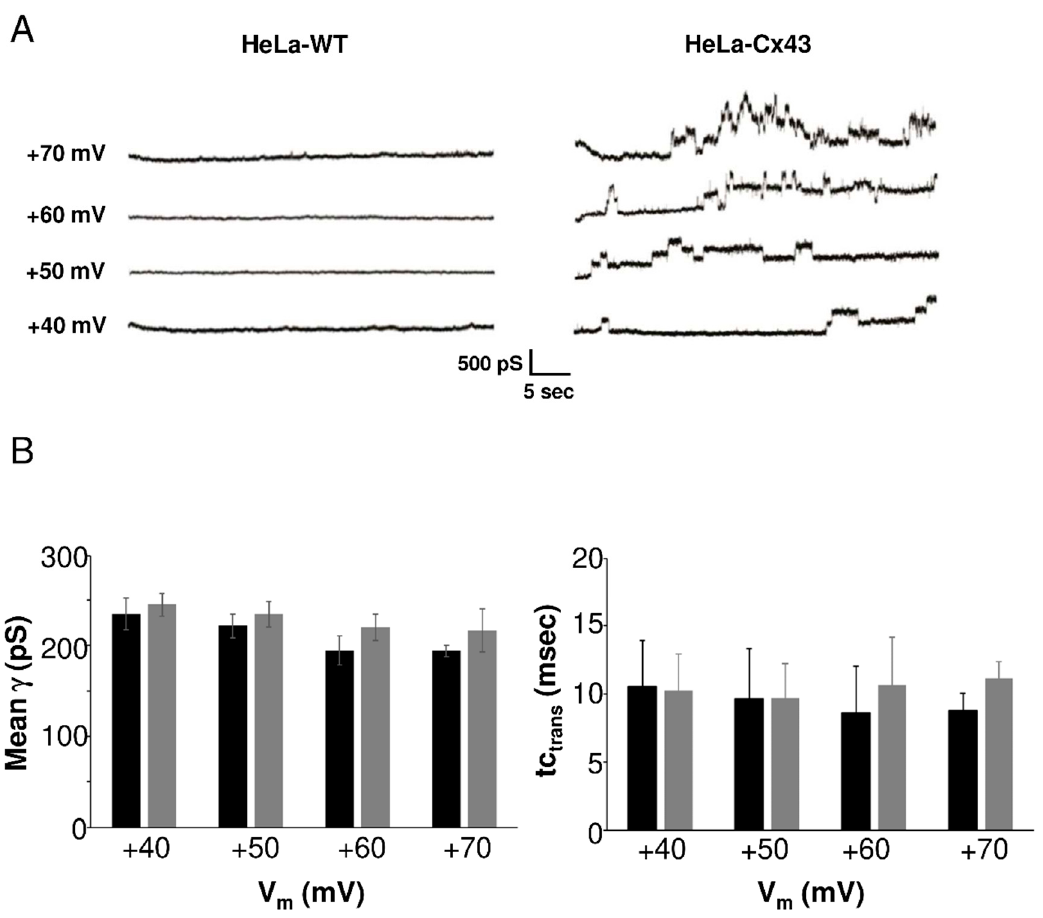
Figure 3. Unitary currents in HeLa-WT and HeLa-Cx43 cells. ( A ) Representative current traces in response to stepping positive membrane potentials (Vm) from − 30 mV to potentials in the range of + 40 to + 70 mV. Unitary event activity was only observed in HeLa-Cx43. ( B ) Average unitary conductance and time constant of the transitions in HeLa-Cx43 obtained by two observers ( N = 4; N = 15; n = 132, 33 traces per Vm step). There were no di ff erences in conductance or time constants recorded at di ff erent voltages (one-way ANOVA with Bonferroni post-test).